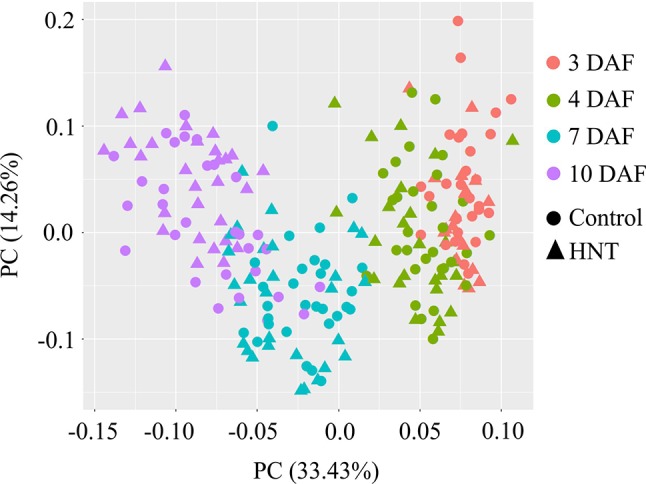
Principal component analysis (PCA) of the metabolite profiles of rice seed development under control and high night-time temperature conditions. Orange, green, blue, and violet colors represent 3, 4, 7, and 10 days after fertilization (DAF). Circle and triangle represent metabolome for control samples and high night temperature treated samples. Five independent biological replicates were used for the metabolomic analysis. Each point corresponds to one replicate from each of the six rice genotypes. HNT, high night-time temperature.